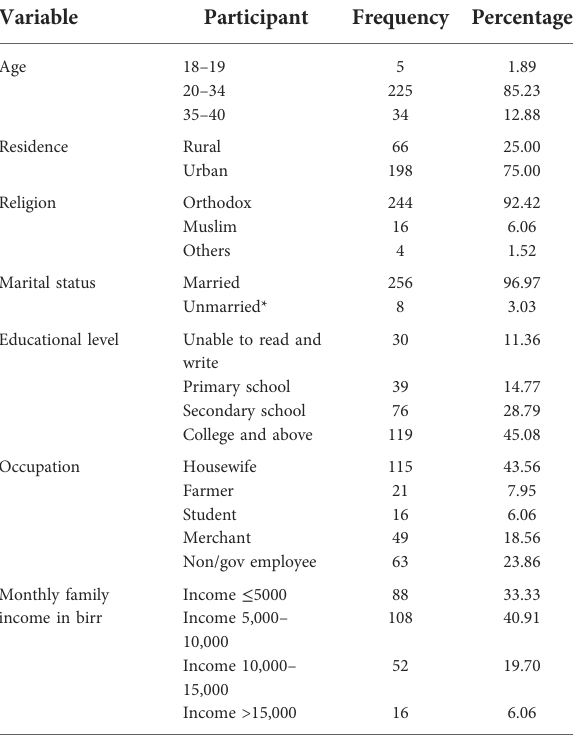
TABLE 1 Sociodemographic characteristics of participants, 2021 [ N =264].